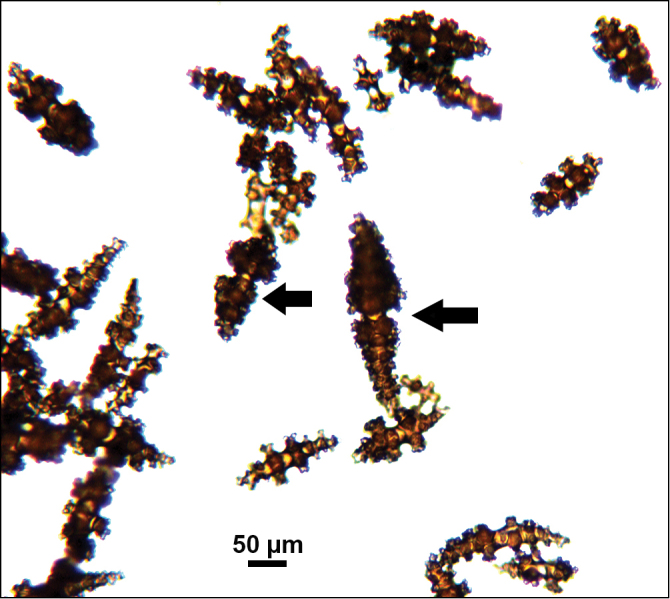
Chromoplexauramarki, SBMNH 423062, light microscopy array of sclerites, 10× magnification. Two sclerites, marked with arrows, are those that define the species (compare with those shown in Figure 34). The large central sclerite, just to left of image center, is > 100 µm in length, while non-capped spindles measure 100–130 µm.